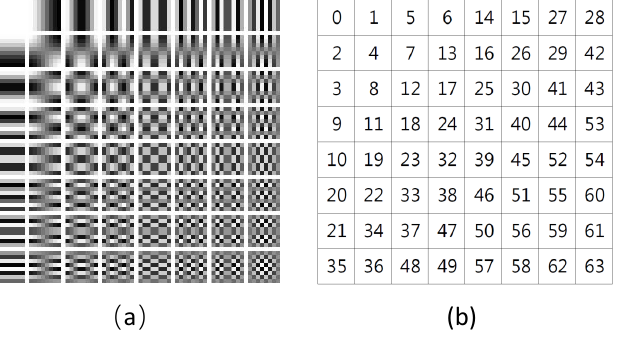
Figure 9. ( a ) The DCT basis images, forming the complete DCT dictionary of size 8 × 8. ( b ) The numbered basis images; the numbers are listed as the shape “Z” from 0 to 63.